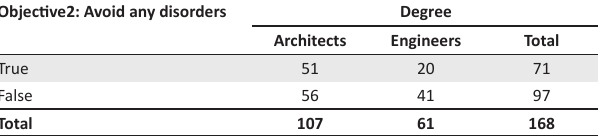
TABLE 7: Objective 2 of seismic rules (avoid disorder). Objective2: Avoid any disorders